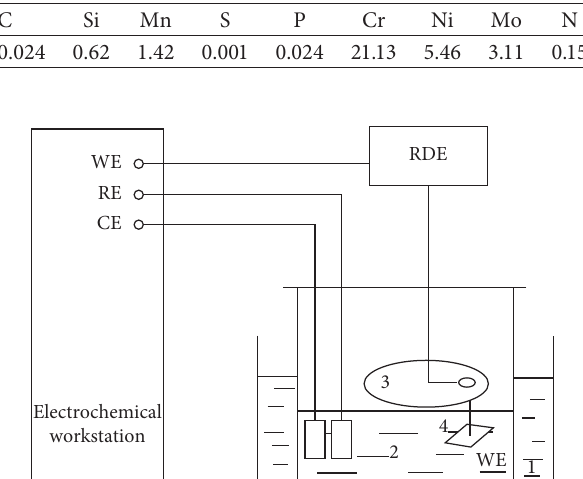
Figure 1: Electrolytic workstation used for dynamic pickling tests. 1, thermostat water bath; 2, electrolyte; 3, rotating disk; 4,